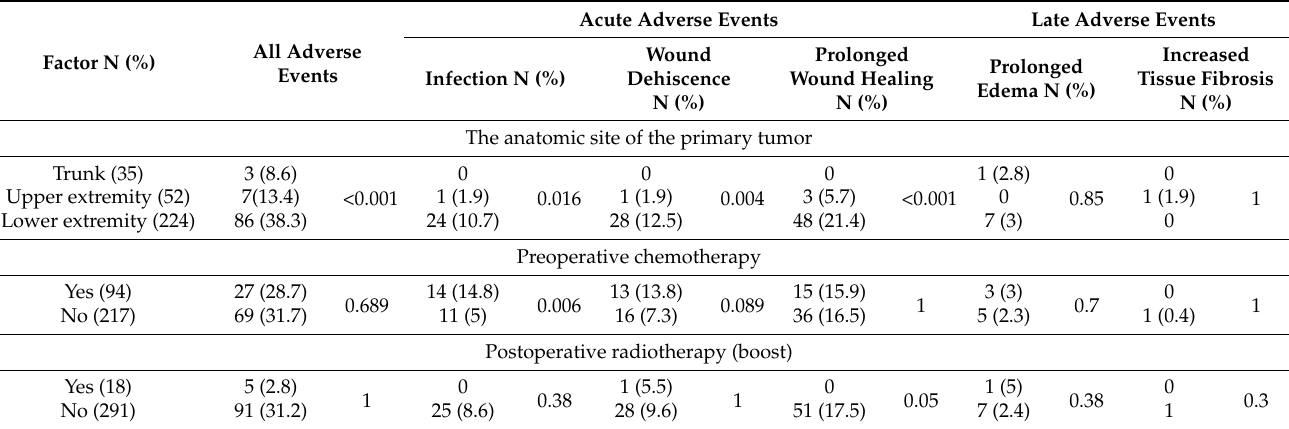
Table 5. Treatment adverse